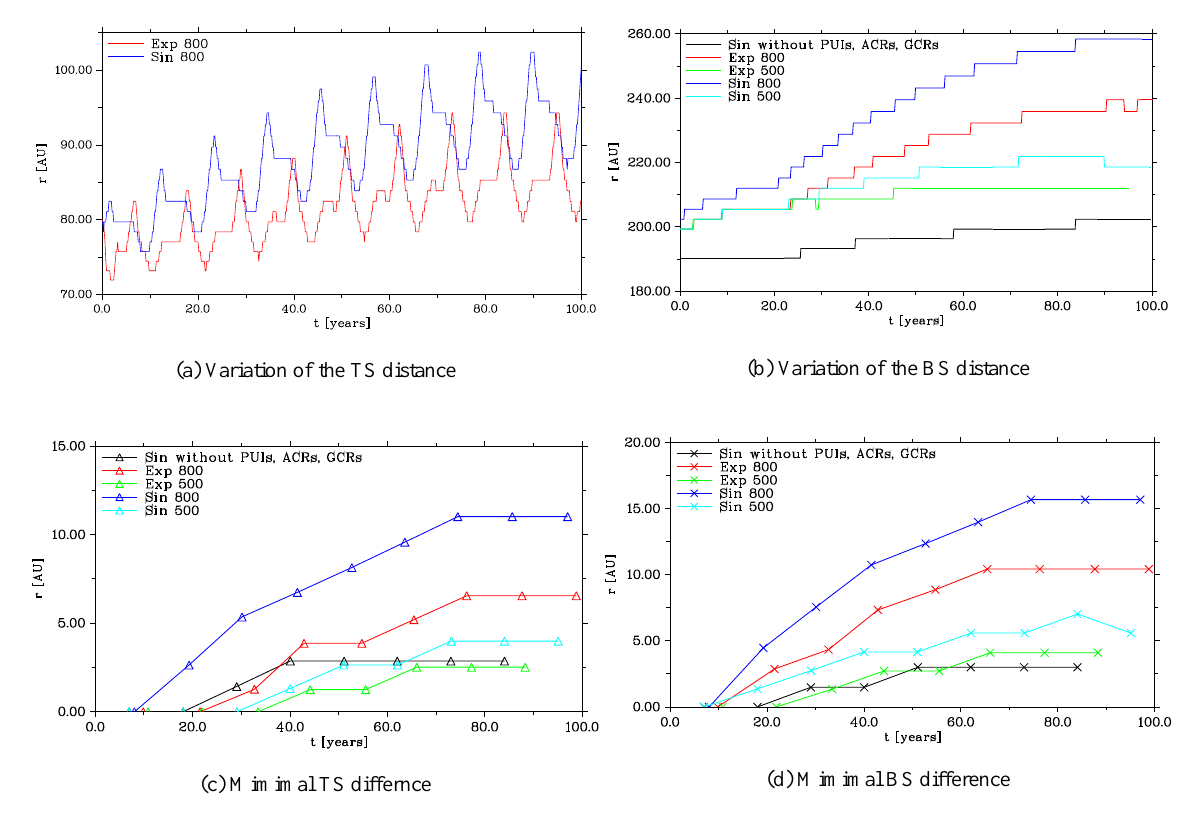
Fig. 4. For five different solar cycle models the variability of the termination shock and bow shock is shown (see text for details). The relative minimal and maximal distance between the terminations shock of a static and dynamical heliosphere during the minimum and maximum phase, respectively, are plotted in the lower